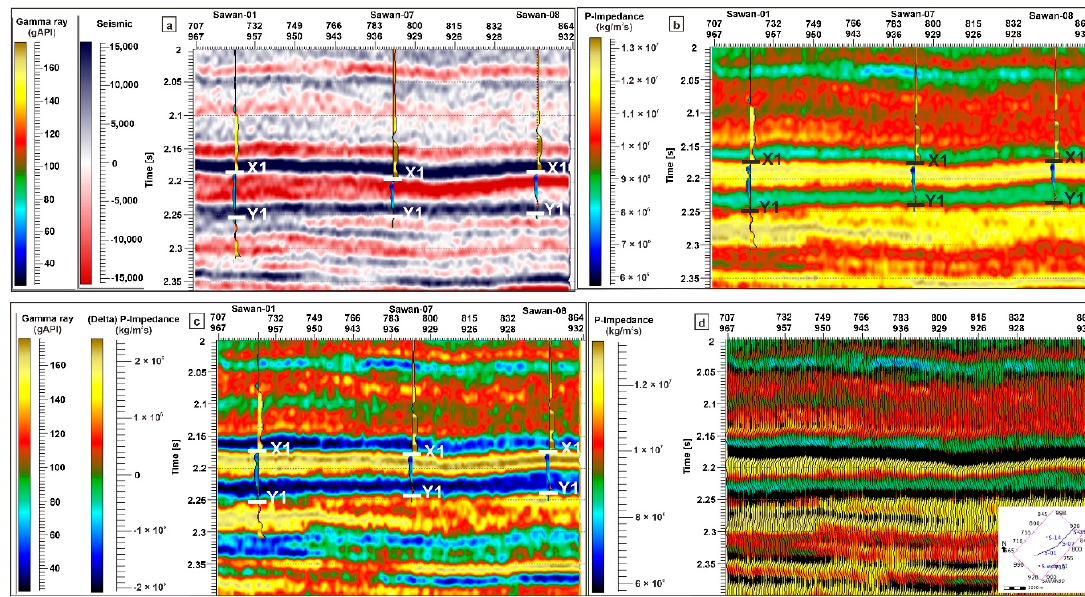
Figure 9. Well-tops, overlay GR (API) log, and S-01, S-07, S-08 wells on ( a ) a seismic section. ( b ) Inverted AI broadband model. ( c ) Inverted AI broadband model with well-tops, overlay GR (API) log, and S-01, S-07, S-08 wells. ( d ) Overlay of seismic section (wiggle) and inverted broadband AI model that shows the same resolution.